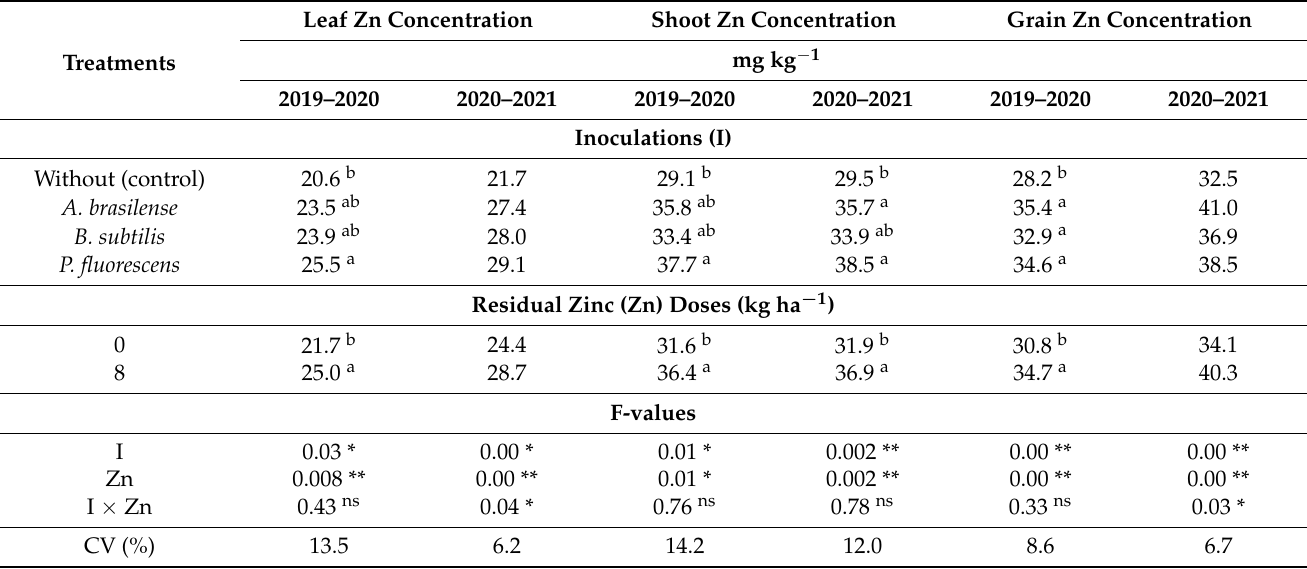
Table 2. Leaf, shoot, and grain zinc (Zn) concentrations of maize as function of residual Zn doses